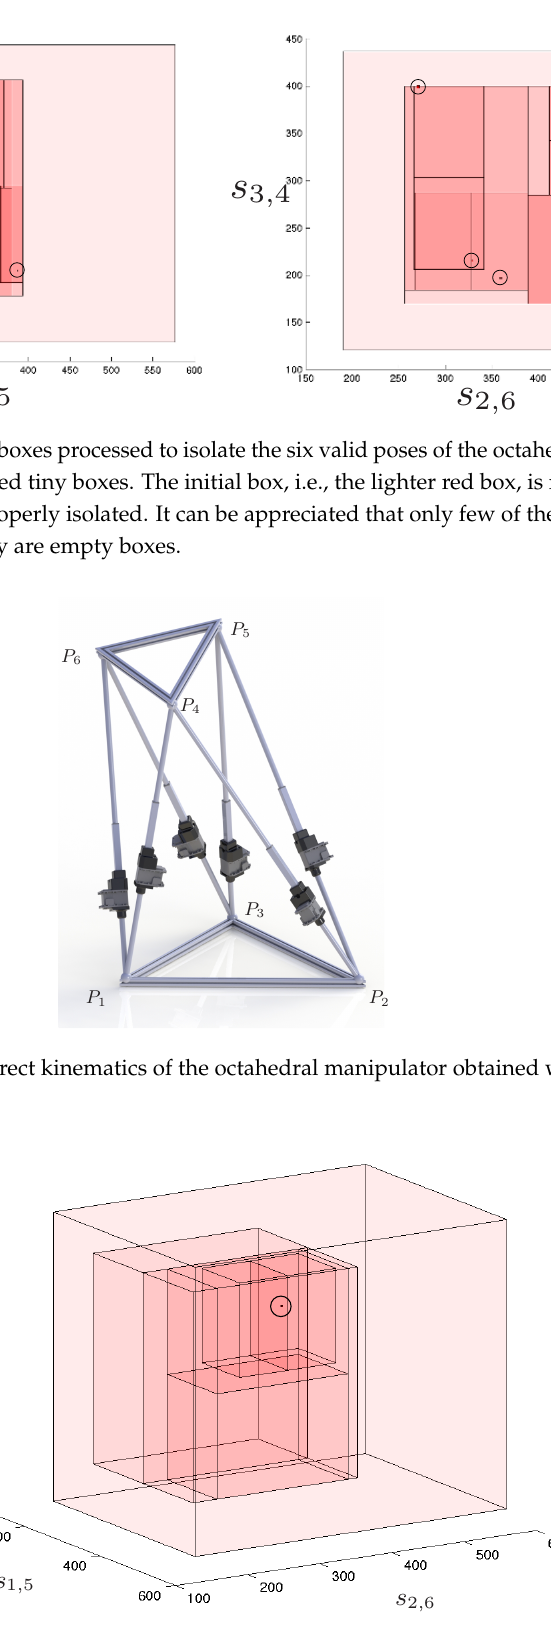
Figure 13. Boxes processed when introducing orientation constraints in the direct kinematics problem for the octahedral manipulator. The solution is the encircled tiny